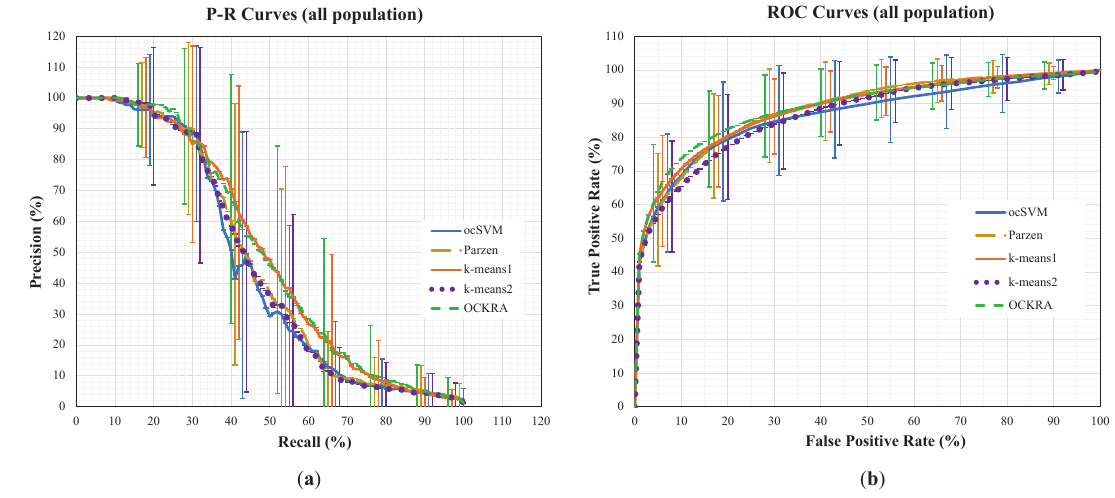
Figure 1. Precision-recall curves ( a ) and ROC curves ( b ) based on the average performance and standard deviation for all